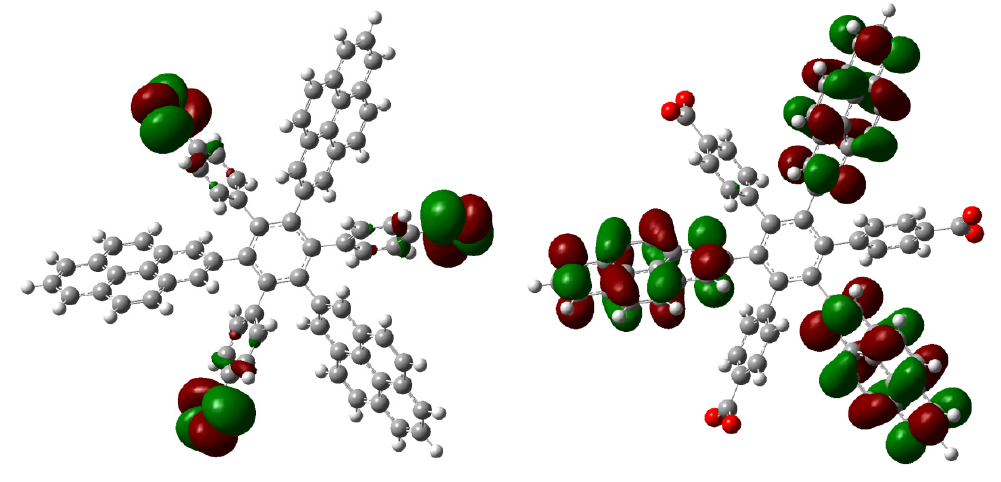
Figure 19. Frontier molecular orbitals for HAB9